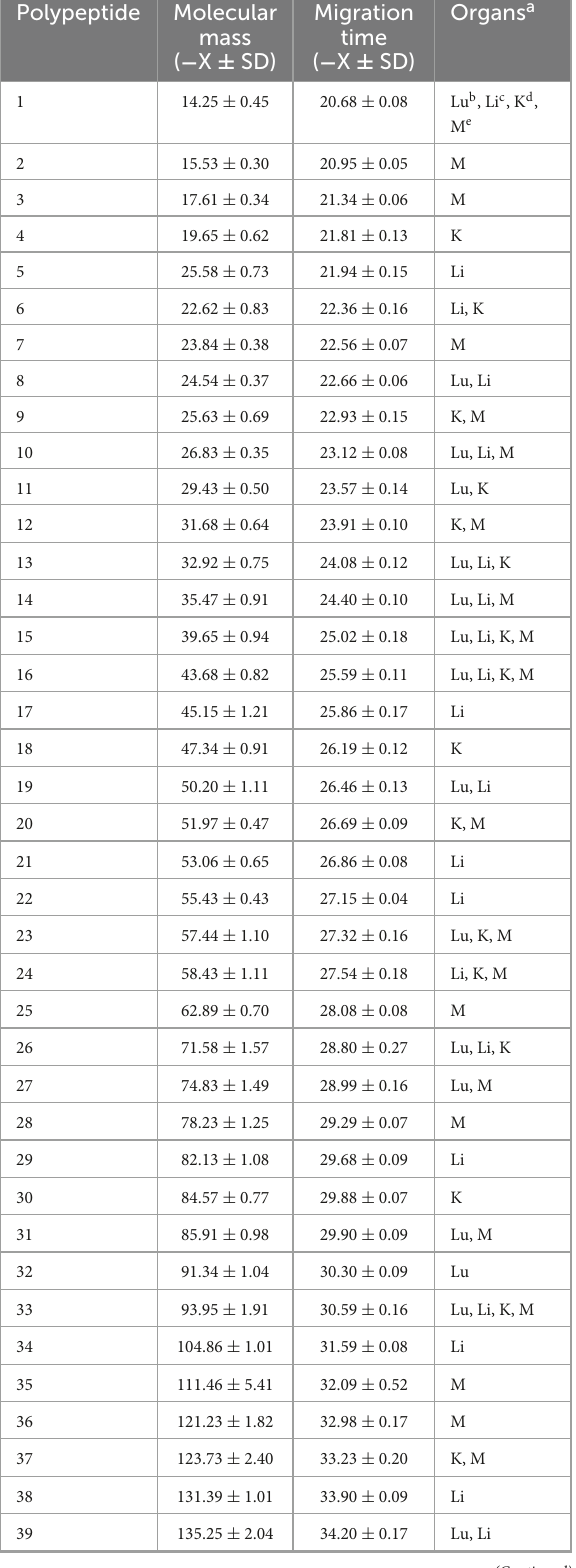
TABLE 1 The polypeptide fragments in the lung, liver, kidney, and skeletal muscle samples.